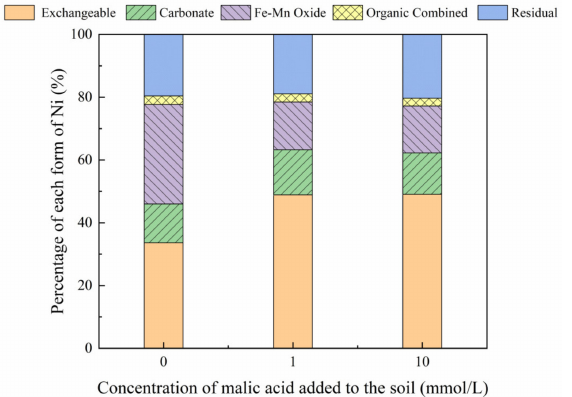
Figure 9. Distribution of different Ni forms in Ni-200 soil after the addition of malic acid (0, 1, 10 mmol/L).